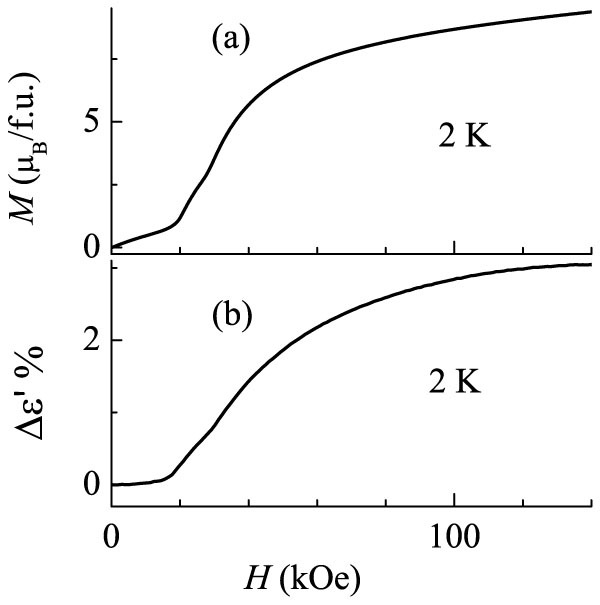
Isothermal magnetization (M(H)) and change (Δε′) in dielectric constant, Δε′ = (ε′H = 0- ε′H)/ ε′H = 0 for Er2BaNiO5.